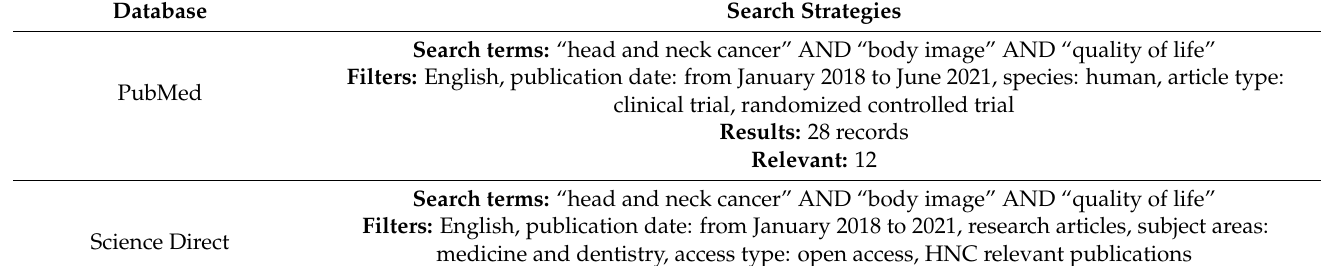
Table 1. Data sources and search strategies. Search